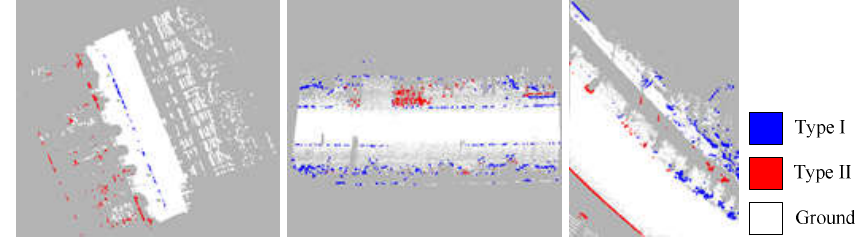
Figure 5.The spatial distributions of the type I and type II